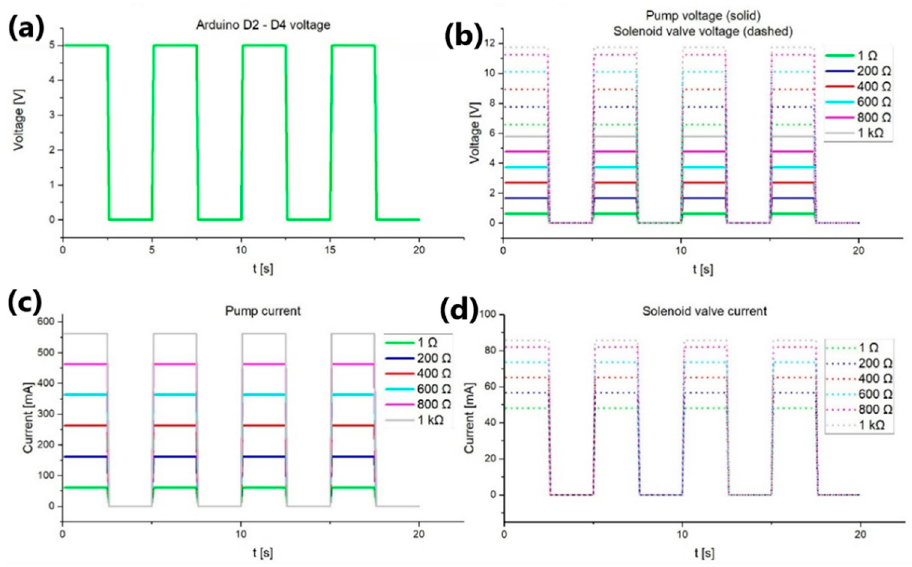
Figure 5. LTSpice simulation output data. ( a ) Arduino digital pin D2 and D4 voltage over time. ( b ) Pump (solid) and solenoid valve (dashed) voltage over time as a function of the adjust resistance. ( c , d ) Pump and solenoid valve current over time as a function of the adjust resistance.